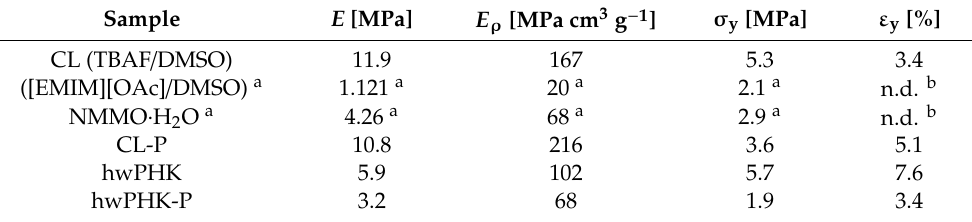
Table 3. Young’s modulus ( E ), specific modulus ( E ρ ), yield strength ( σ y ), and yield stress ( ε y ) as obtained from uniaxial compression testing of the prepared